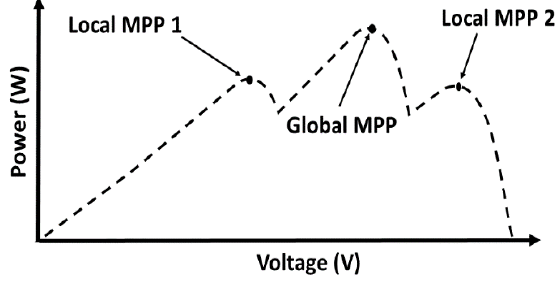
Fig. 2. Characteristics of photovoltaic generators